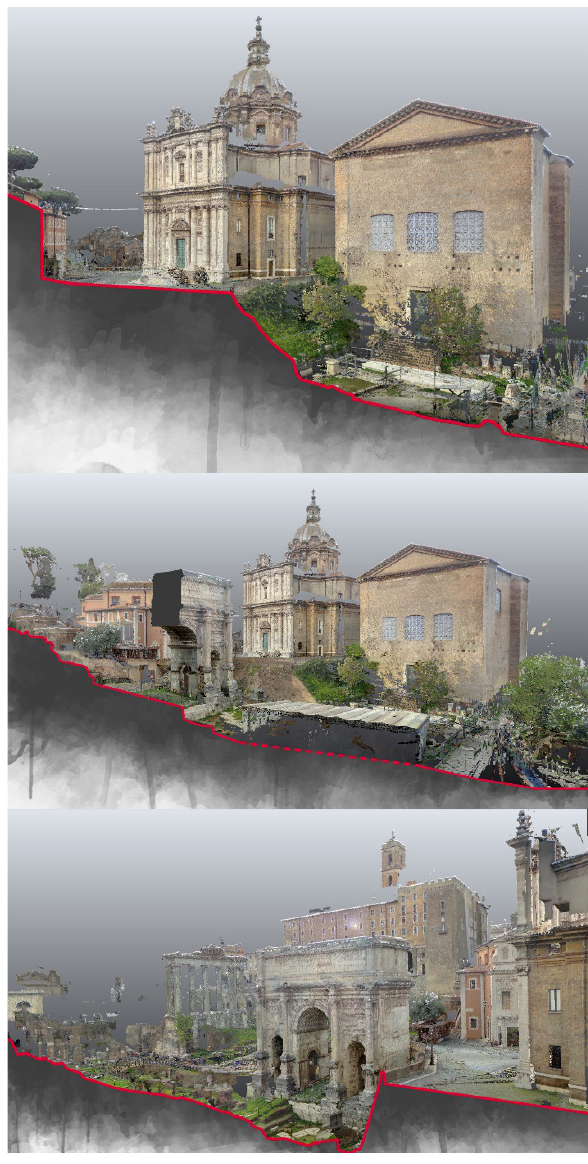
Figure 2: Perspective sections obtained by modifying the clipping box of ReCap. The particular orographic condition is highlighted by the complexity of the sections. The survey campaign through the laser scanner, and subsequent elaborations, has highlighted the complexity of the place, rich in countless finds, which without any discretization, are captured by the instrument. Being able to separate the parts inside the cloud of points in such a complex system would be impossible. Finds, friezes, parts of columns, monuments still intact or reassembled for anastylosis, the green system, the terraces, the retaining walls ... are part of an indivisible unicum that precisely in this singularity hides its beauty and extraordinary nature.